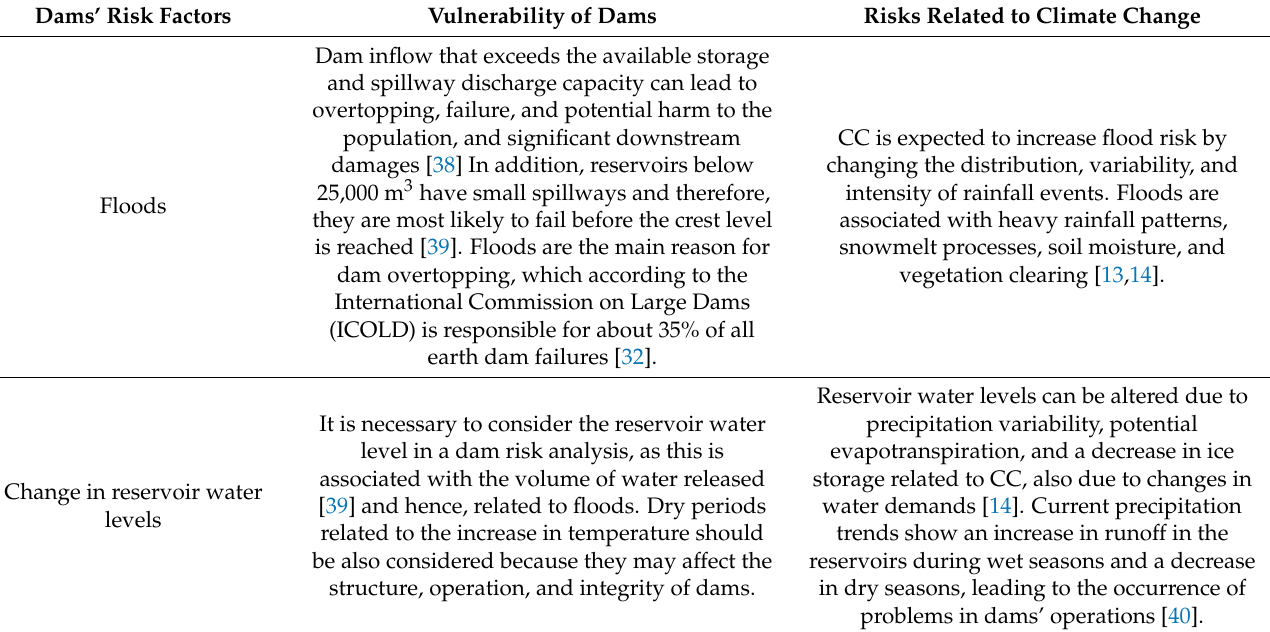
Table 1. Possible climate change impacts in dams. Adaptation of (Fluix á -Sanmart í n et al., 2018.). Dams’ Risk